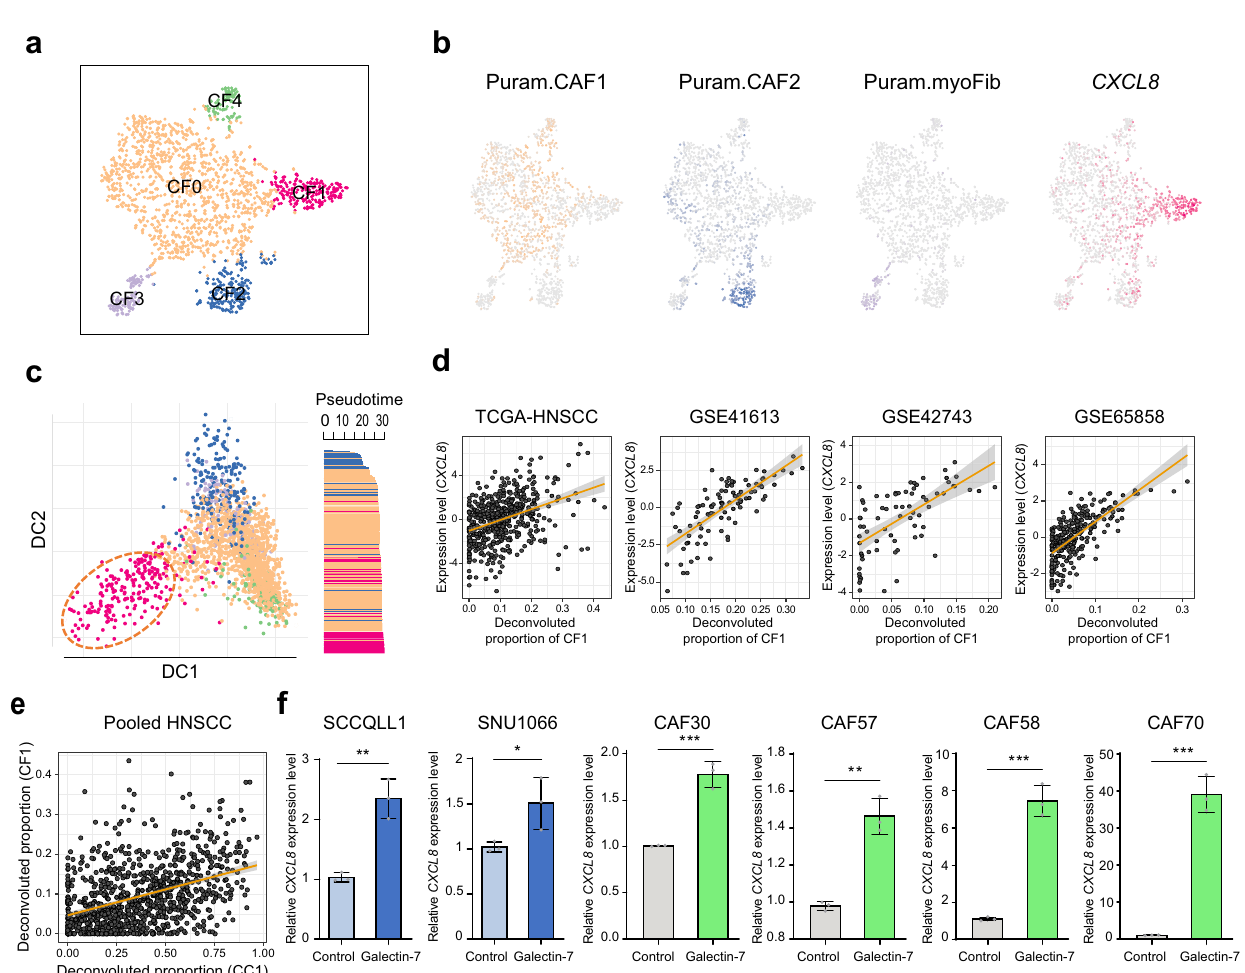
Fig. 4 | Fibroblasts-derived COL1A1 expression interacts with CD44 in malig- nantcells.a TissuetypesofNL,LP,CA,andLN( left )andthepseudo-times( right )of the cells are shown in UMAP plots. b Distributions of the pseudo-time in the fi broblasts across the tissue types are shown. c A heatmap shows the inter- dependentexpressionoftheligand-receptorpairswithstepwiseexpressionduring HNSCCprogressionbetween fi broblastsandmalignantcells. d Thecellproportions forexpressedcells of COL1A1 and CD44 are shownin fi broblasts(F-)and malignant cells(C-)acrossthetissuetypes( e.g .,F-NL, fi broblastsinNL;C-NL,malignantcellsin NL) from our data ( top ) and that of GSE103322 ( bottom ). e The correlation plot shows COL1A1 expression levels in fi broblasts and CD44 expression levels in epi- thelial cells in HNSCC patients. The gray shading represents 95% con fi dence